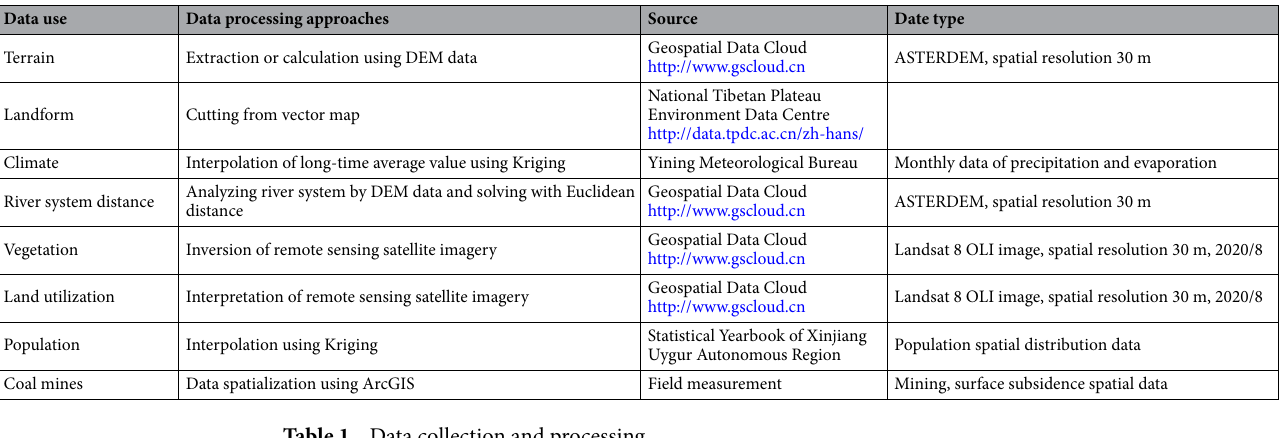
Table 1. Data collection and processing.